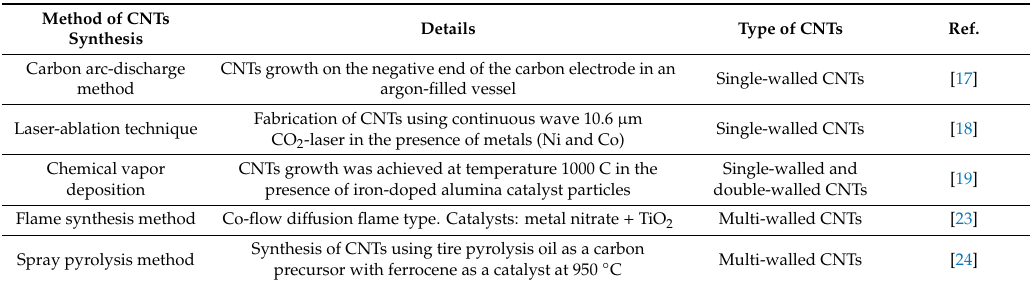
Table 1. Main methods of carbon nanotubes (CNTs)